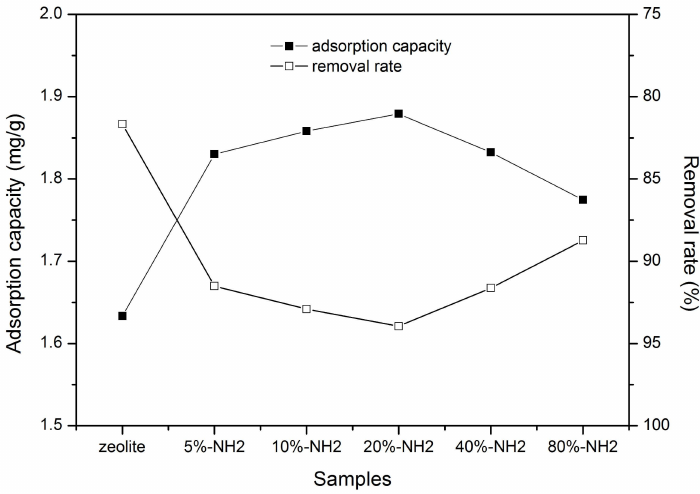
Figure 11. Adsorption properties of zeolite and amino functionalized zeolite samples with different silane dosage towards